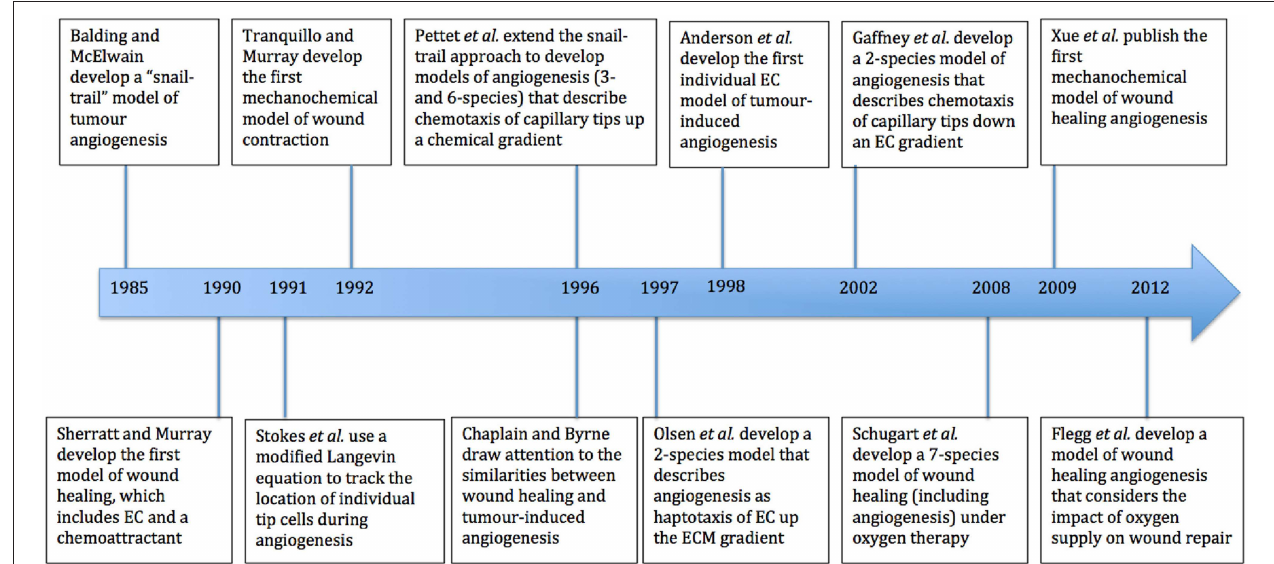
FIGURE 2 | Timeline of major mathematical models of wound healing and of the process of angiogenesis. EC refers to endothelial cells and ECM to extracellular matrix.